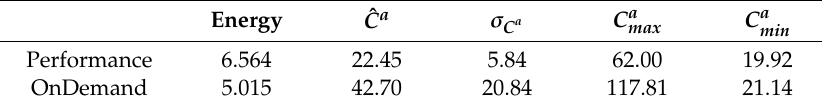
Table 6. Performance and OnDemand governors with F max .